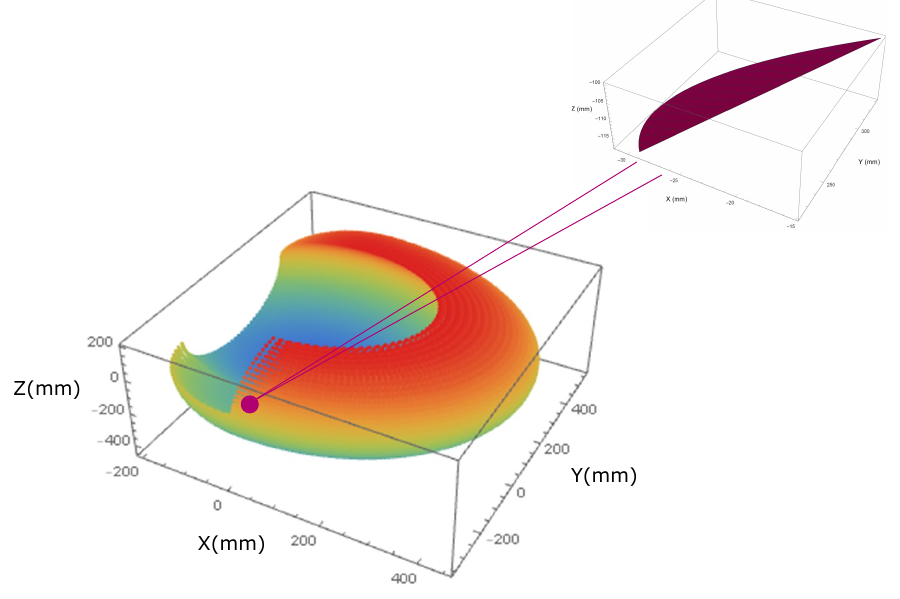
Figure 12. Workspace of the upper-limb